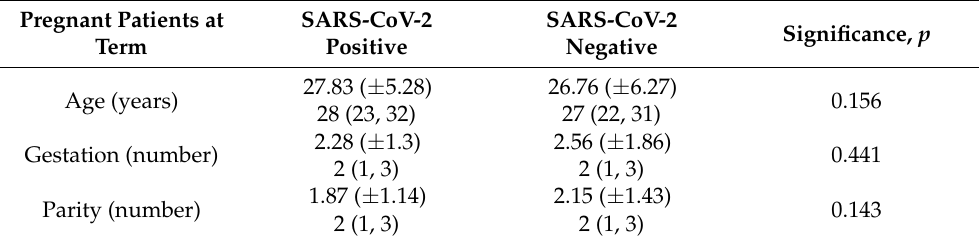
Table 1. Patient characteristics: mean values (and standard deviations) on the upper line, and median values (quartile 1, quartile 2) on the lower line of each value